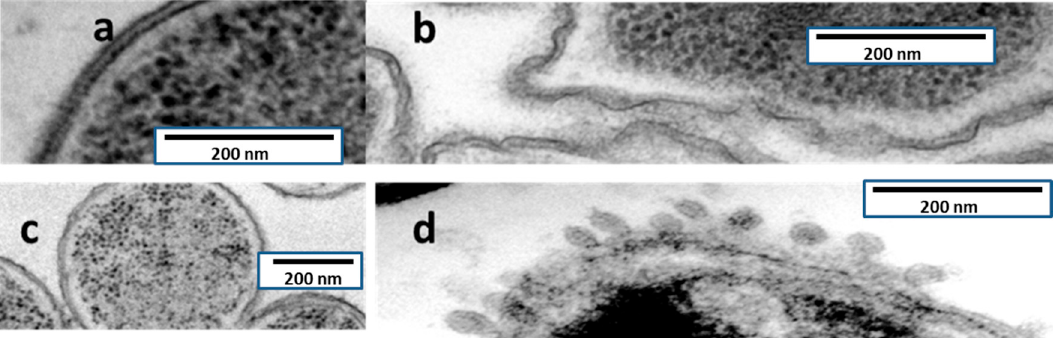
Figure 4. TEM electromicrographs of P. aeruginosa PA116136 ( a ) untreated and ( b ) AMP38-treated; and Serratia marcescens NIMA strain( c ) untreated and ( d )